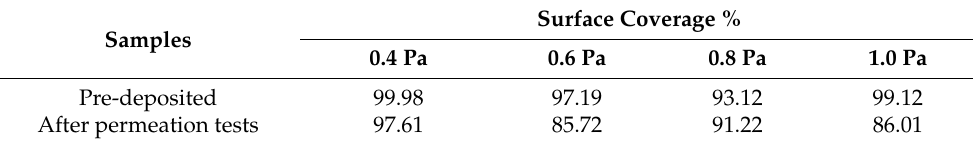
Table 2. Surface coverages of the films before and after deuterium permeation tests. Samples